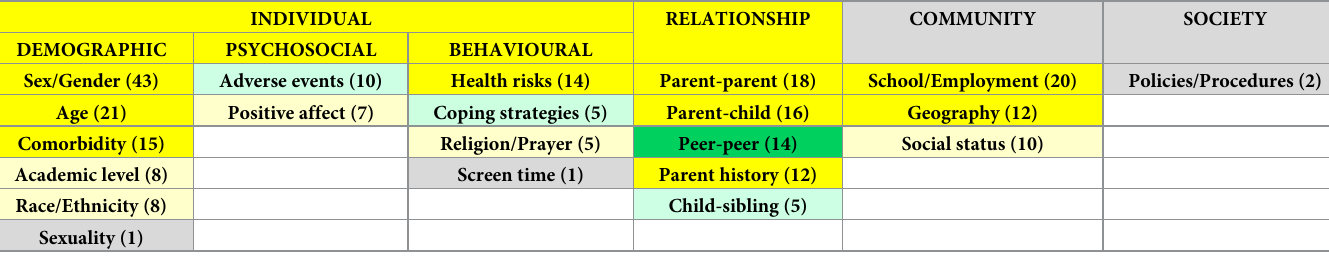
Table 2. Factors associated with children and young people’s mental health in the English-speaking Caribbean.